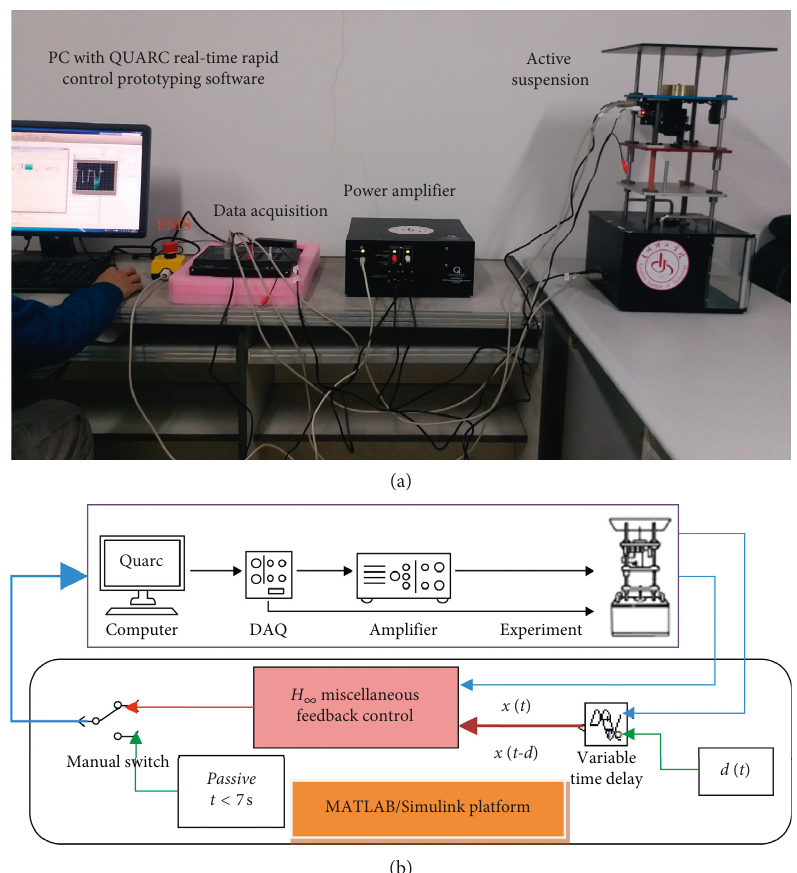
Figure 10: Active suspension experiment. (a) Two DOF active suspension workstation. (b) Block diagram of control